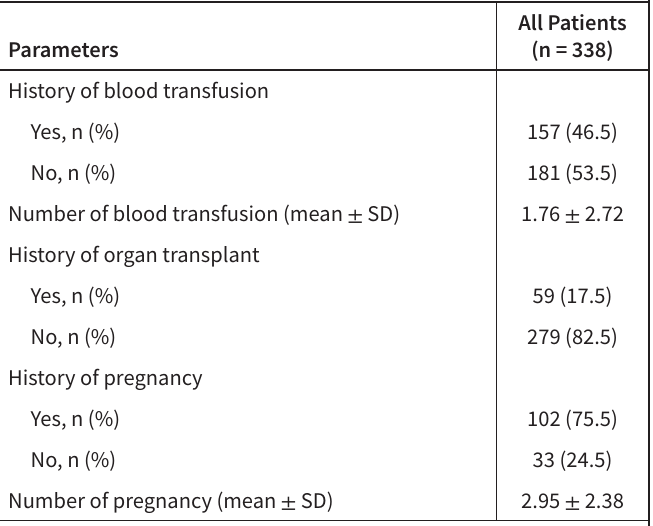
Table 1. Demographic and Clinical Data of Patients on the